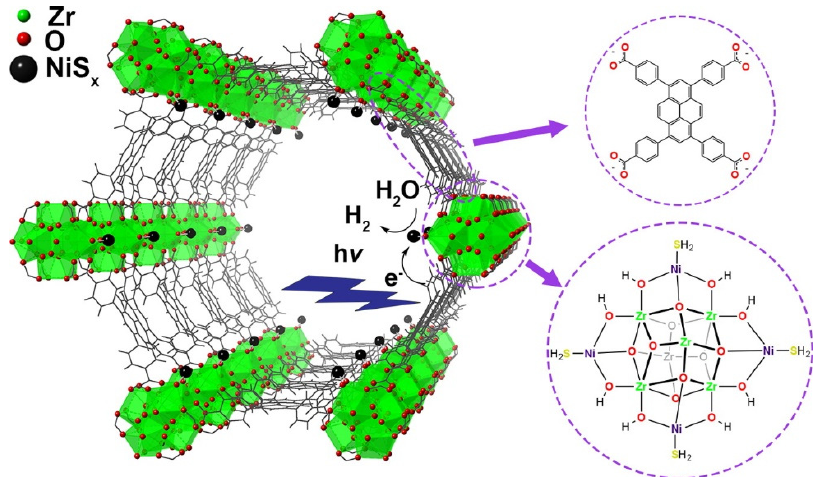
Figure 5. Idealized structure of NiS x -functionalized NU-1000. The ligand and proposed structure of the atomic layer deposition in metal–organic frameworks (AIM)-metalated cluster are also shown. Green = Zr, Red = O, Black = NiS x . Adapted with permission from [60]; Published by American Chemical Society, 2016.